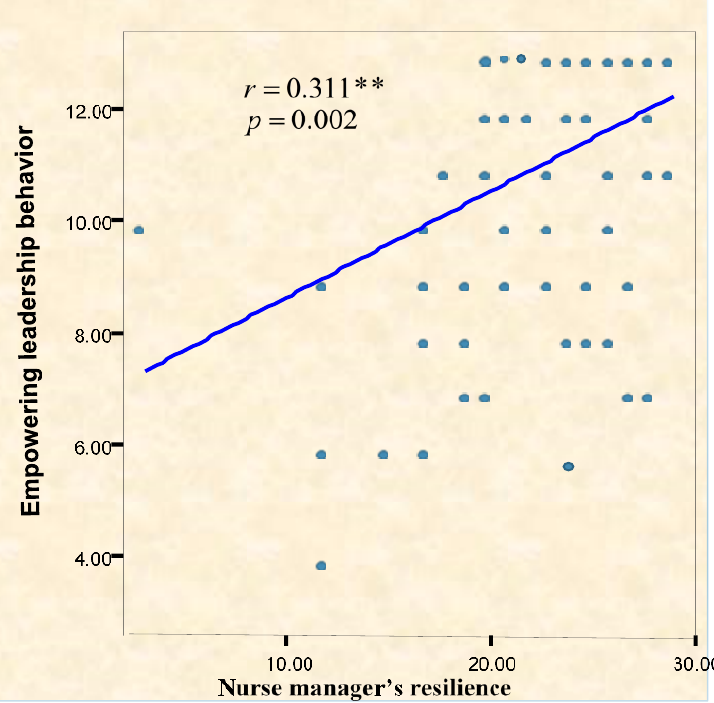
Figure 3. Correlation between total nurse manager’s resilience skills levels and total staff nurses’ perception of empowering behavior during COVID-19. r: Pearson coefficient (**) Highly statistically significant at p < 0.001.